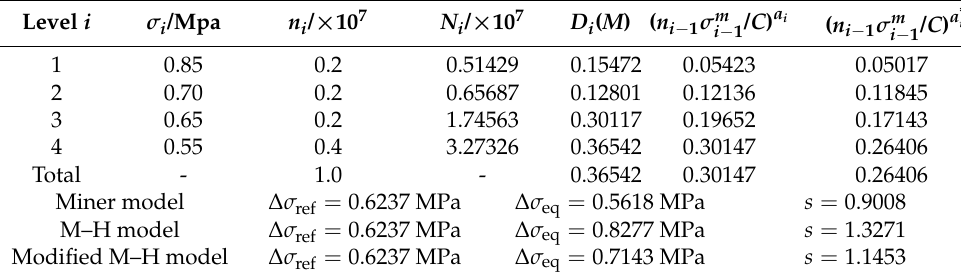
Table 3. Four-level loads designed in the high-and-then-low loading